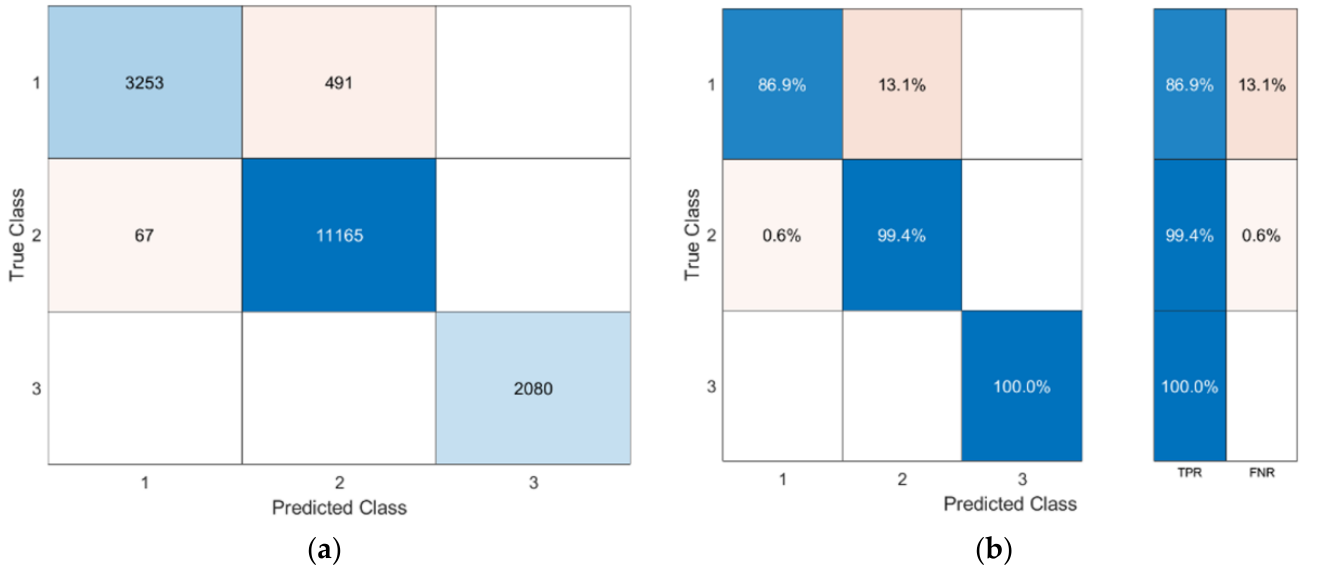
Figure 8. Confusion matrix corresponding to the highest accuracy shown in Table 8: ( a ) confusion matrix showing numerical values ( b ) TPR and FNR (in percentages). Table 9. Performance of fault detection using SFS with KNN (five-fold cross-validation).